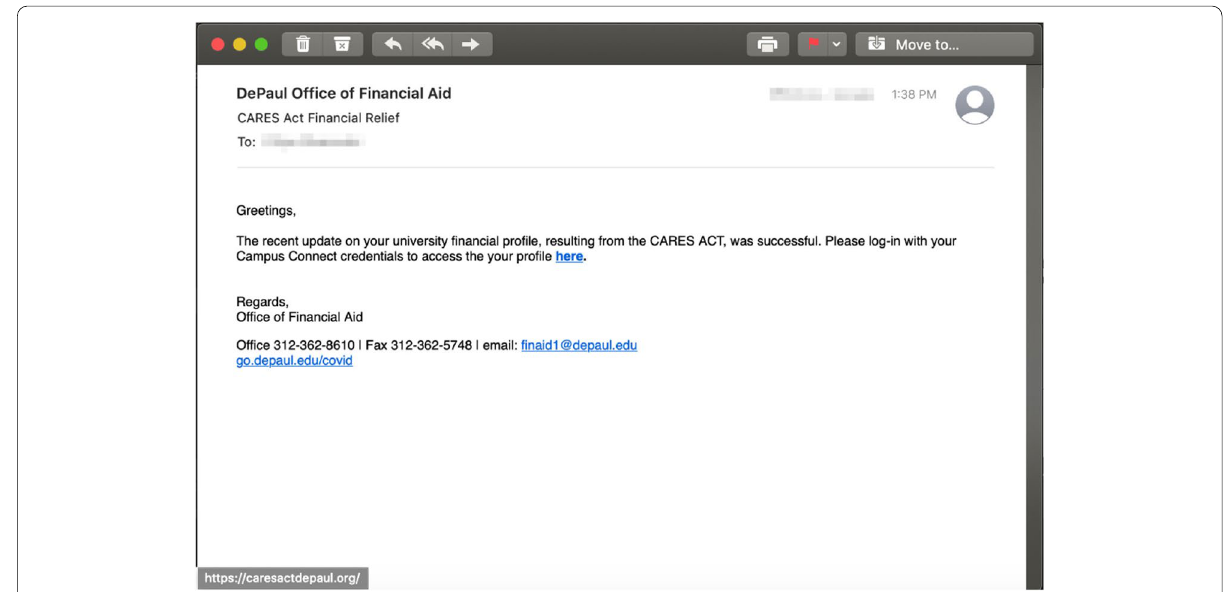
Fig. 2 Phishing email incorporating the authority principle